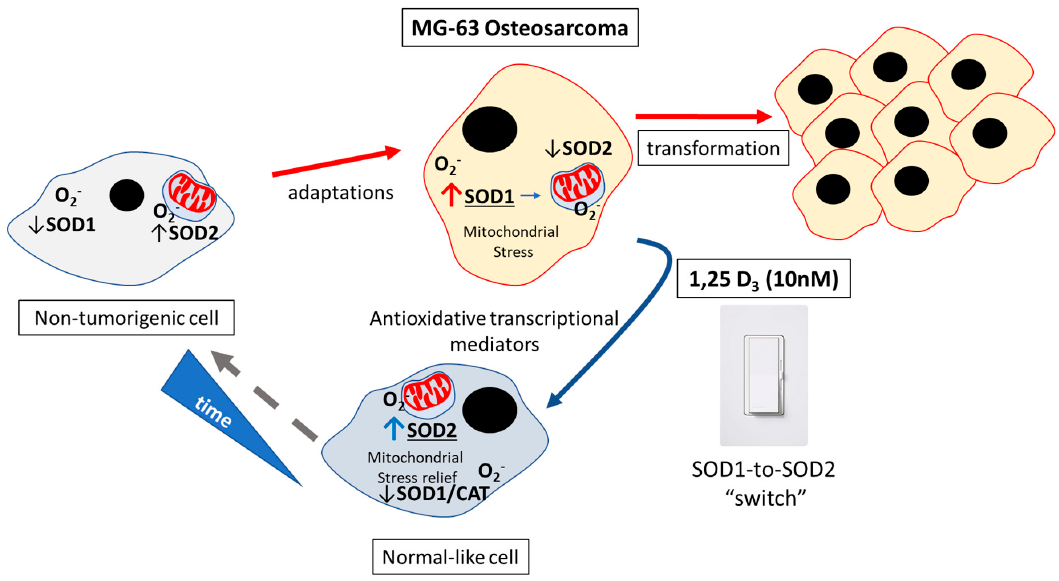
Figure 4. Schema representing the SOD1-to-SOD2 switch in MG-63 osteosarcoma cells after vitamin D treatment. Cancer cells generally express elevated levels of SOD1 (superoxide dismutase 1) compared to SOD2 (superoxide dismutase 2) with respect to non-tumorigenic cells. This indicates a higher reactive oxygen species (ROS) burden in the cancer cells. Vitamin D treatment in a dose- and time-dependent manner promotes an increase in SOD2 levels, with concomitant decreases in antioxidant CAT (catalase) and SOD1 levels, indicative of mitochondrial stress relief via enhanced SOD2 activity.